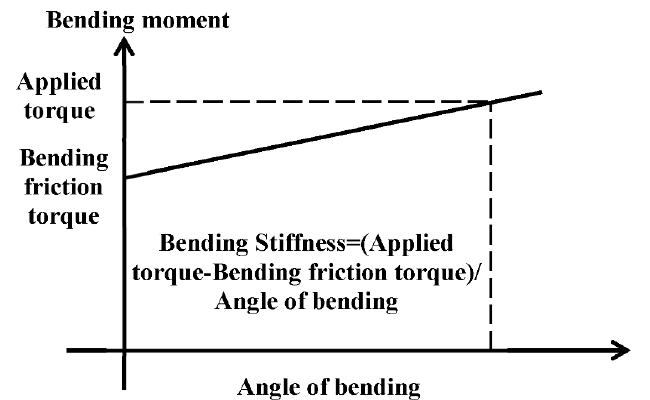
Figure 2. Ideal bending characteristics of a ball joint.